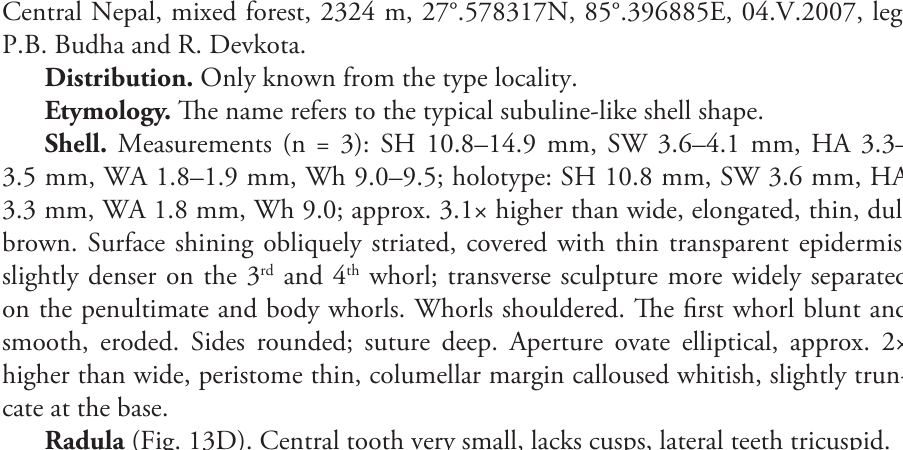
Central Nepal, mixed forest, 2324 m, 27°.578317N, 85°.396885E, 04.V.2007, leg. P.B. Budha and R.